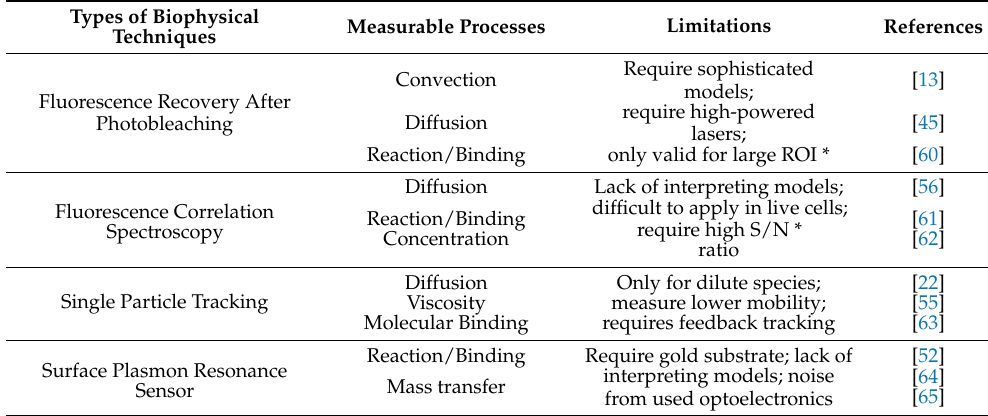
Table 1. Comparisons of various types of experimental methods for the measurement of biomolecular kinetics and/or transport